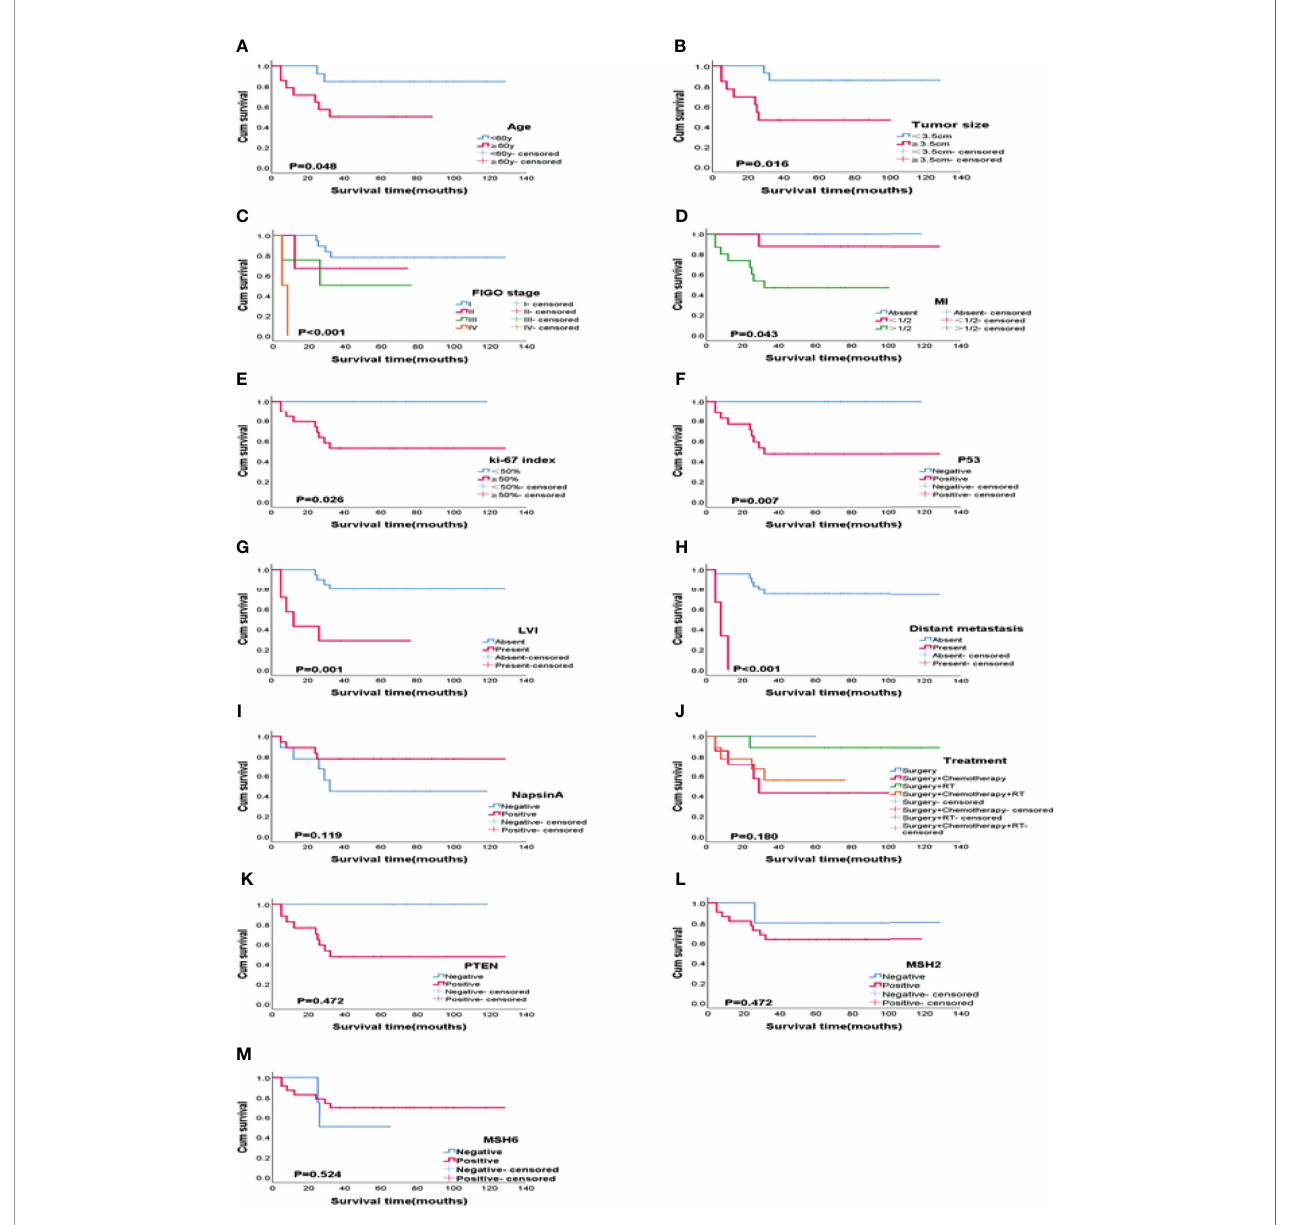
FIGURE 4 | Kaplan-Meier plots of OS according to variables on univariate analysis. (A) Age (P = 0.048), (B) Tumor size (P = 0.016), (C) FIGO stage (P < 0.001), (D) MI (P = 0.043), (E) Ki-67 index (P = 0.026), (F) P53 (P = 0.007), (G) LVI (P = 0.001), (H) Distant metastasis (P < 0.001), (I) Napsin A (P = 0.119), (J) Treatment (P = 0.180), (K) PTEN (P = 0.472), (L) MSH2 (P = 0.472), (M) MSH6 (P = 0.524). MI, myometrial invasion; LVI, Lymphovascular